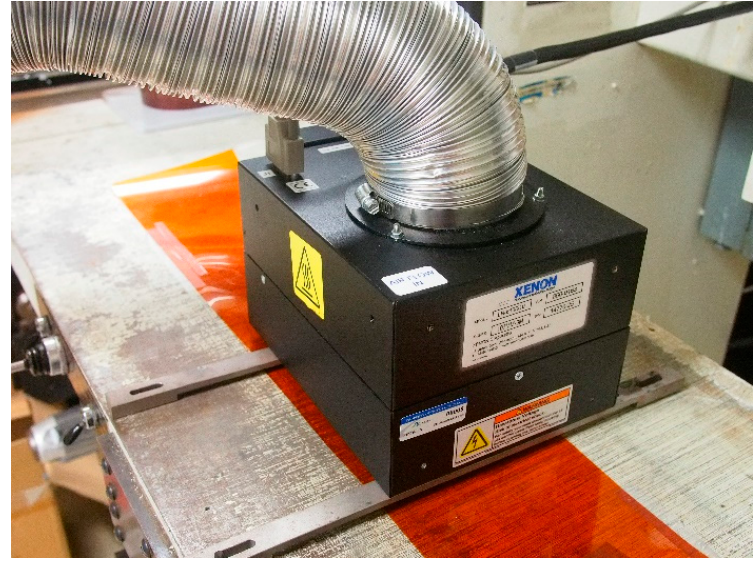
Figure 1. Xenon Sinteron-2000 system used for developing the CNT ink.